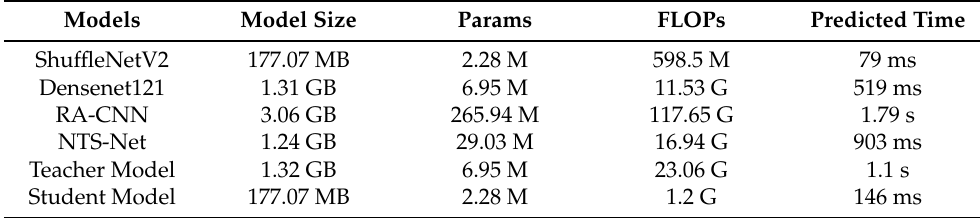
Table 5. The comparison of the Params and FLOPs predicted by the